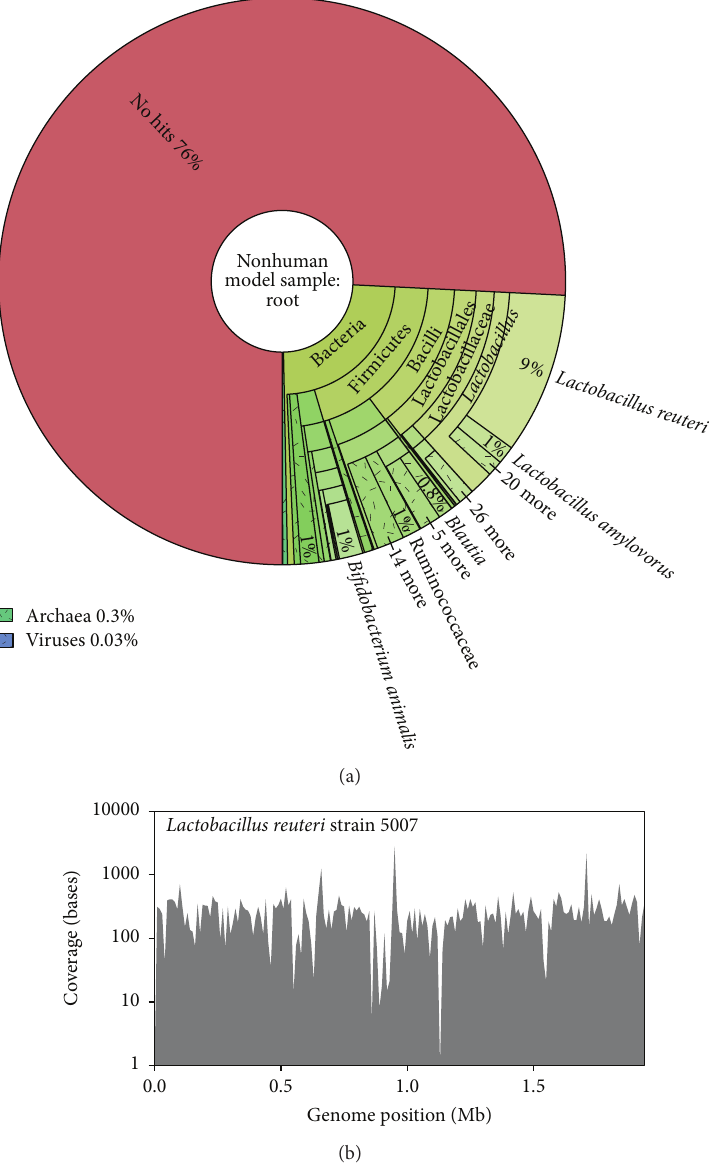
Figure 4: Nonhuman model sample classified using Kraken. (a) Classification of all reads represented by Krona chart. (b) Genome coverage across the 1.9 Mb genome of a reference strain from the most dominant bacterial species identified, L. reuteri .